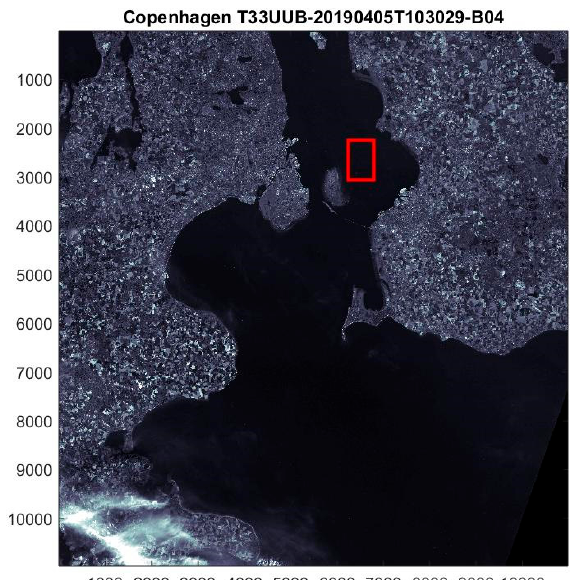
Figure 2. East part of Denmark in the red band B4 (m = 3) from 5 April 2019, 10:30 a.m. UTC. The red box is a ROI in the strait of Øresund surrounding Copenhagen airport.